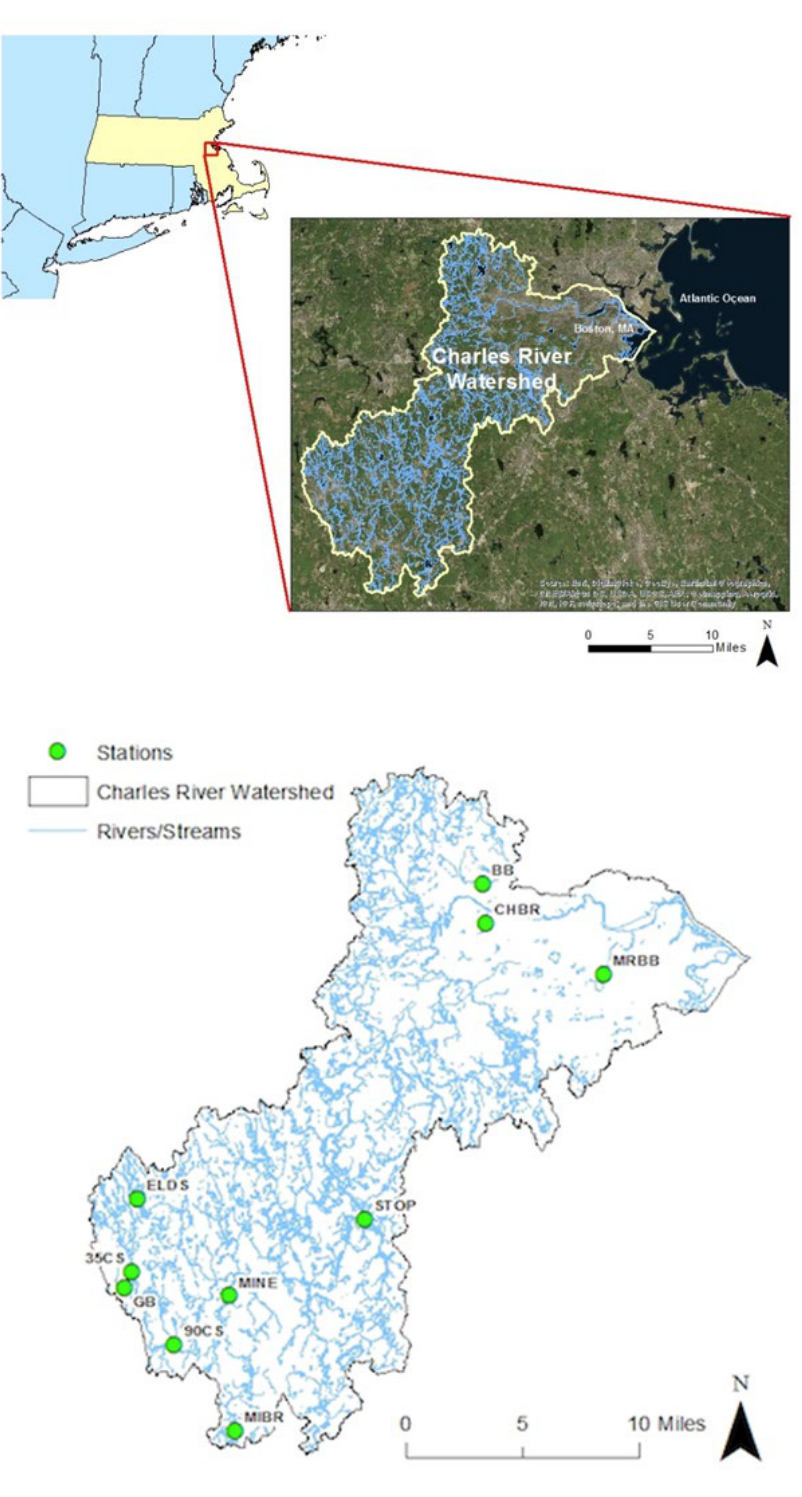
Figure 1. The 10 sampling stations in the Charles River watershed. Beaver Brook (BB), Cheesecake Brook (CHBR), Muddy River Babbling Brook (MRBB), Charles River Mainstem 1 (35CS), Charles River Mainstem 2 (90CS), Echo Lake Down Stream (ELDS), Stop River (STOP), Mine Brook (MINE), Godfrey Brook (GB), and Miscoe Brook (MIBR).